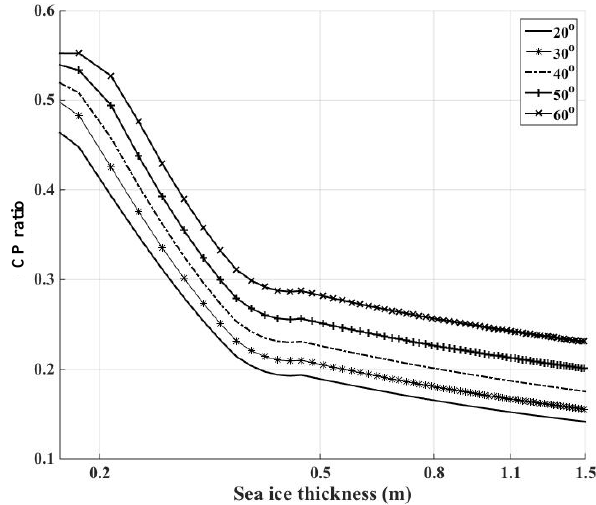
Figure 4. The simulated sea ice growth process. Blue: sea ice thick- ness; red: sea ice surface temperature; green: the volume fraction of brine inclusions.